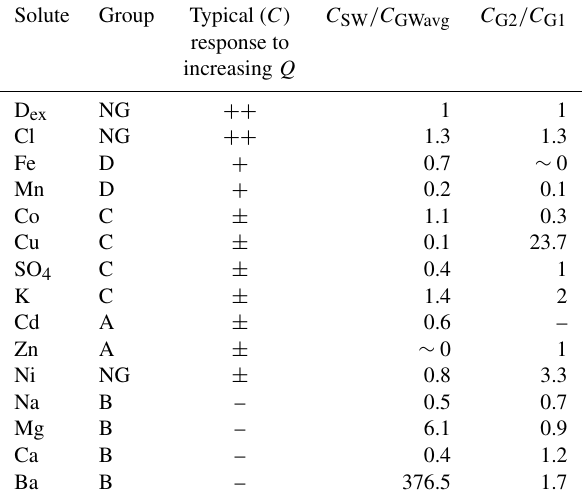
Table 3. Summary of the groups of the solutes (A–D, based on the relative concentrations during all four events; Fig. 6; NG indicates that this solute is not assigned to a group), the typical response of so- lute concentrations to increasing discharge ( ++ : strong enrichment, mean R x > 1 . 5; + : enrichment, mean R x between 1 and 1.5; –: di- lution, and mean R x < 1; ± : mixed response), and ratios between the average concentrations in soil water ( C SW ) and groundwater ( C GWavg ) as well as the groundwater from riparian wells ( C G1 ) and hillslope wells ( C G2 ; see Table 2). See Figs. 5 and 6 for exam- ple concentration–discharge relationships for each group of solutes. The solutes are sorted according to their typical response.